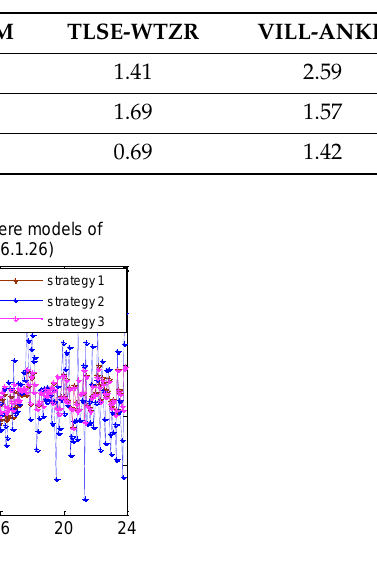
Table 4. The clock di ff erence RMS of 7 days under three ionosphere models.